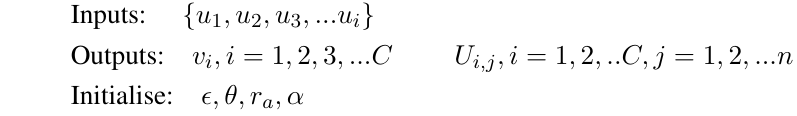
Algorithm 3. The subtractive fuzzy cluster means (SUBFCM)